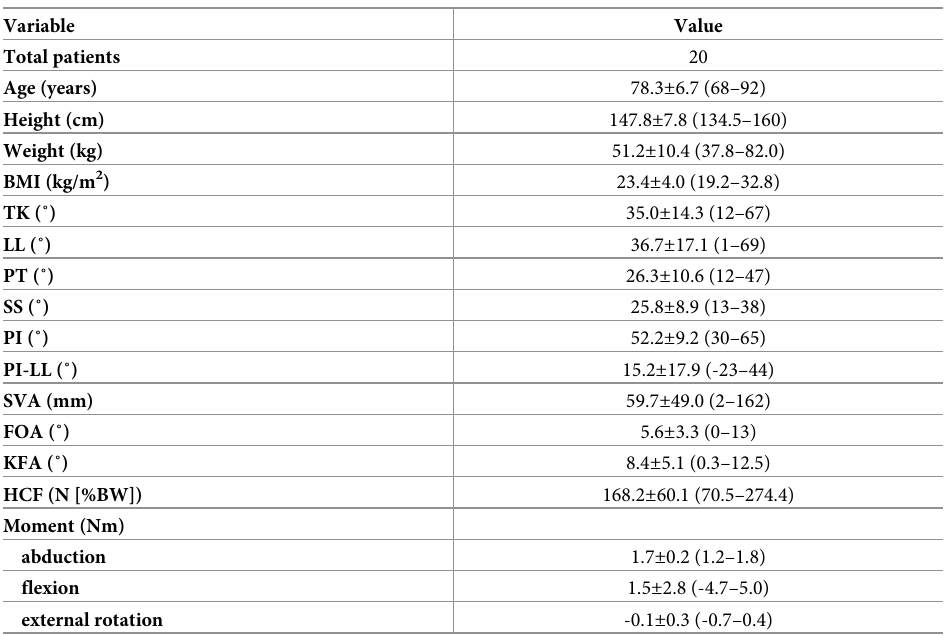
Table 1. Clinical characteristics of all patients.